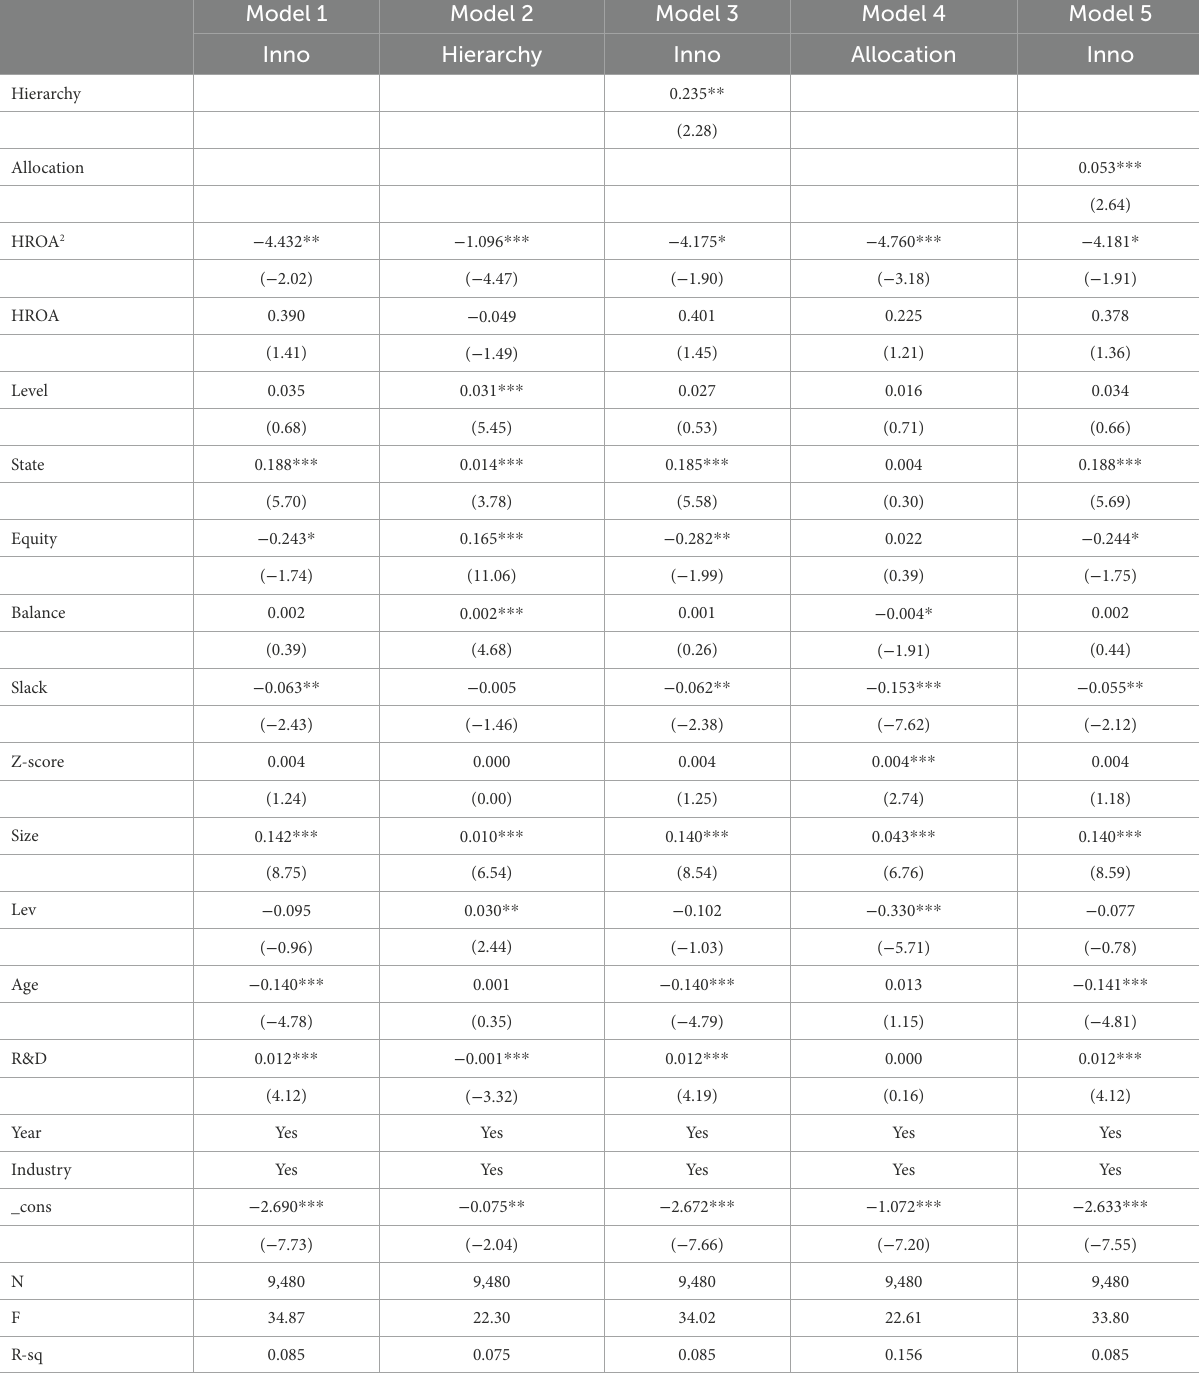
TABLE 4 Results of the nonlinear effect of the performance feedback on technology